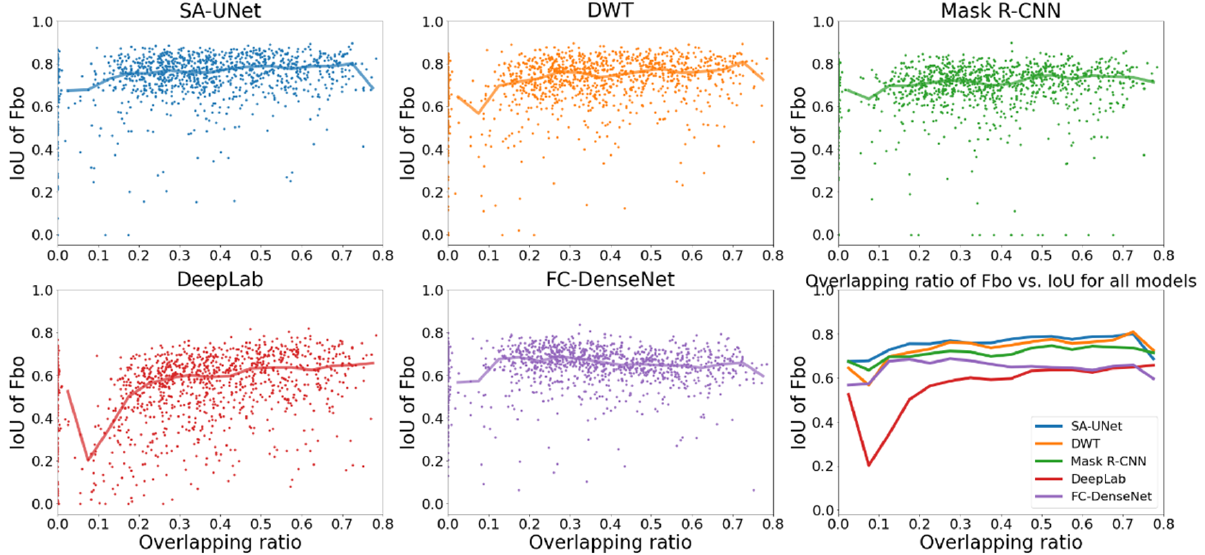
Figure 9. Comparison of IoU of Fbo vs. OR for all models (different colors represent different models: blue: SA-UNet, orange: DWT, green: Mask R-CNN, red: DeepLab, purple: FC-DenseNet).